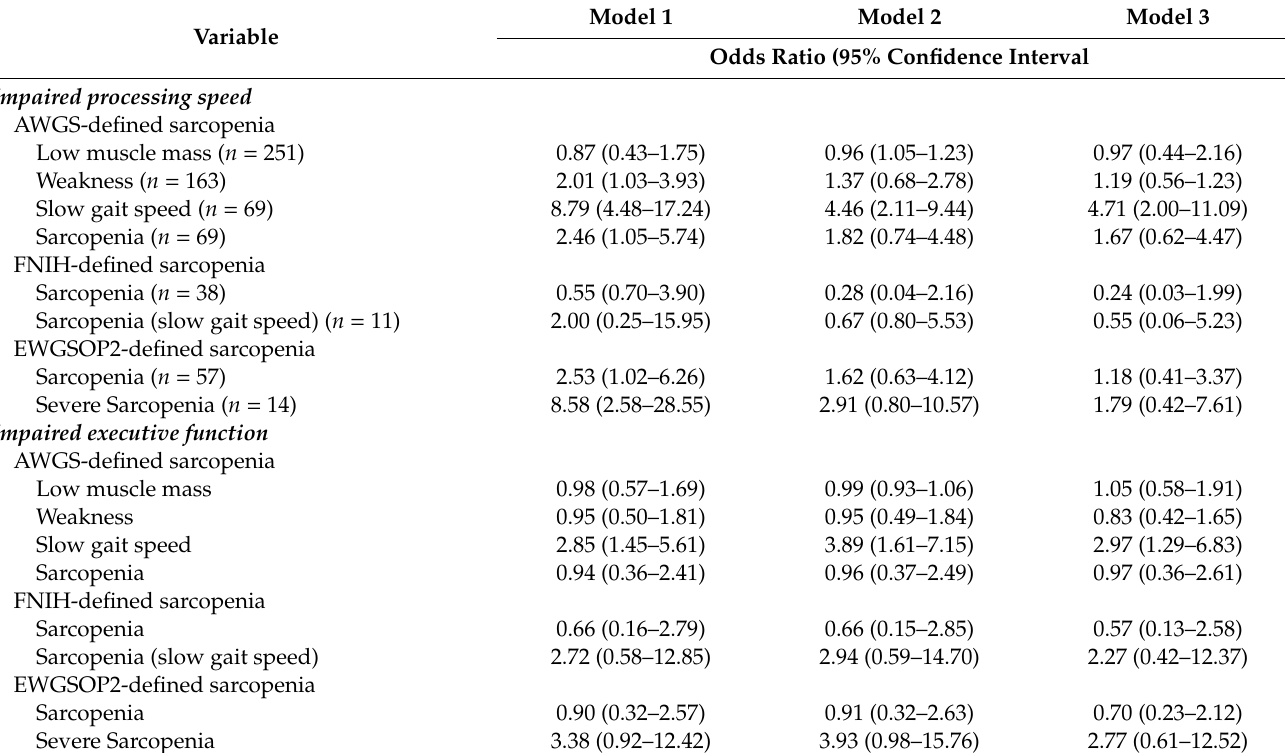
Table 4. Associations between sarcopenia and impairment of di ff erent cognitive domains in women ( n =